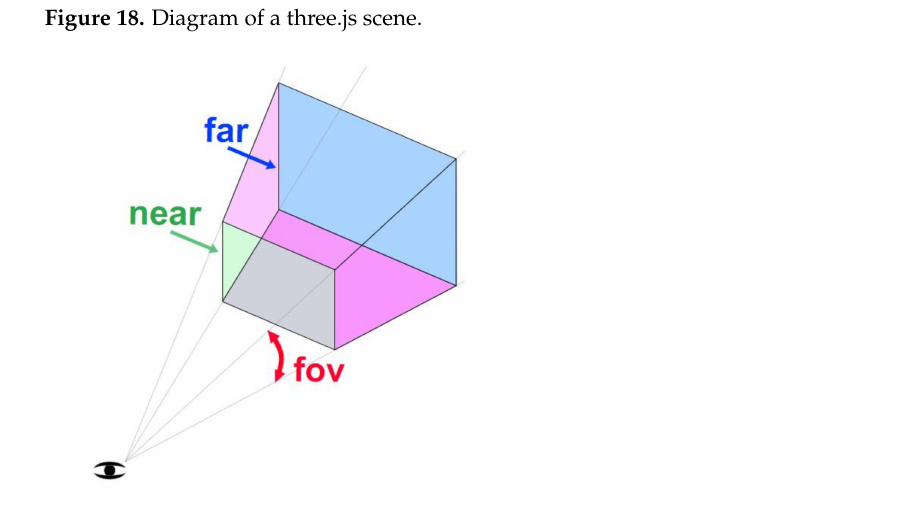
Figure 19. Representation of “frustum”.